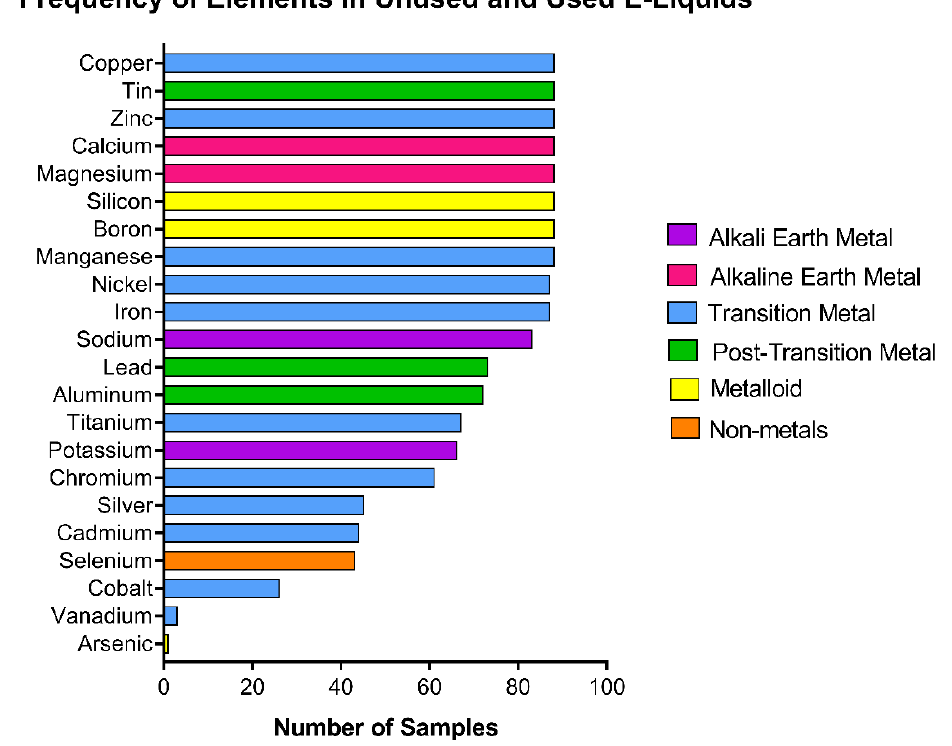
Figure 1. Frequency of elements in unused, gently used, and heavily used e-liquids. Hierarchy of 22 elements screened in 89 samples from 10 brands of first-generation e-liquids. Color coded by periodic table group. Table 1. Brand, sample types, average individual element concentrations, and total concentrations